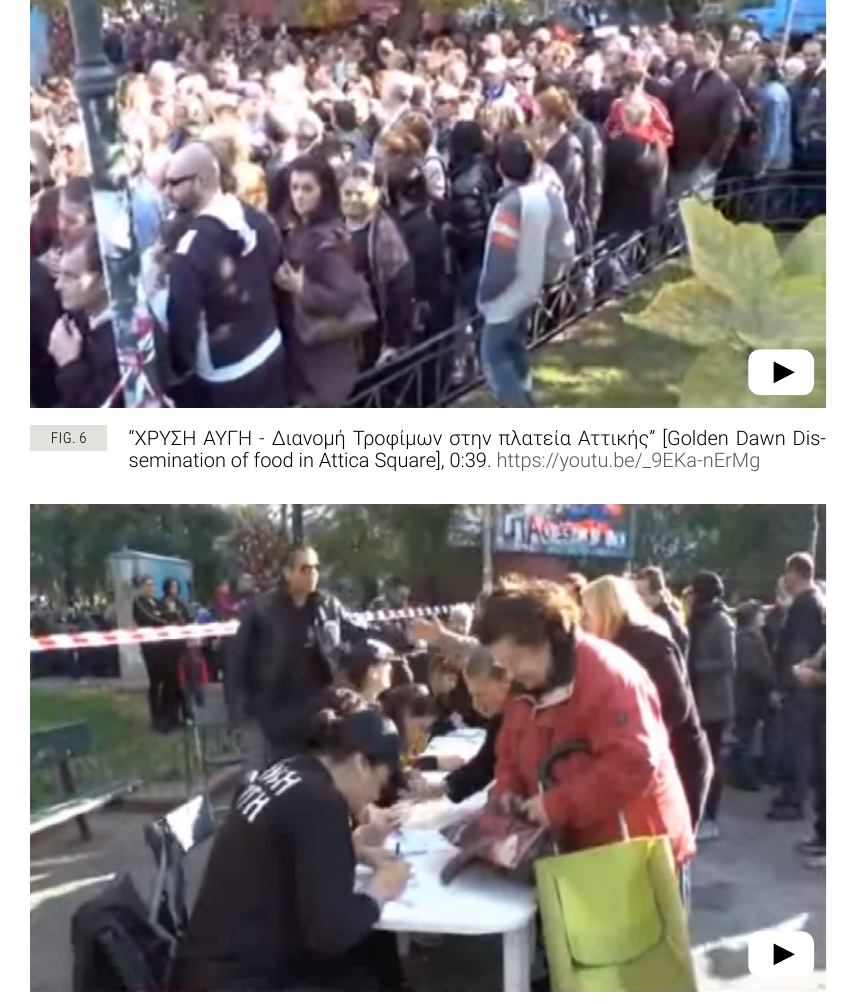
The protesters sing the national anthem followed by the Golden Dawn anthem. Then the speaker calls the audience to shout with him: “Long Live Nationalism!” “Long Live our leader!,” “Long Live Golden Dawn!”